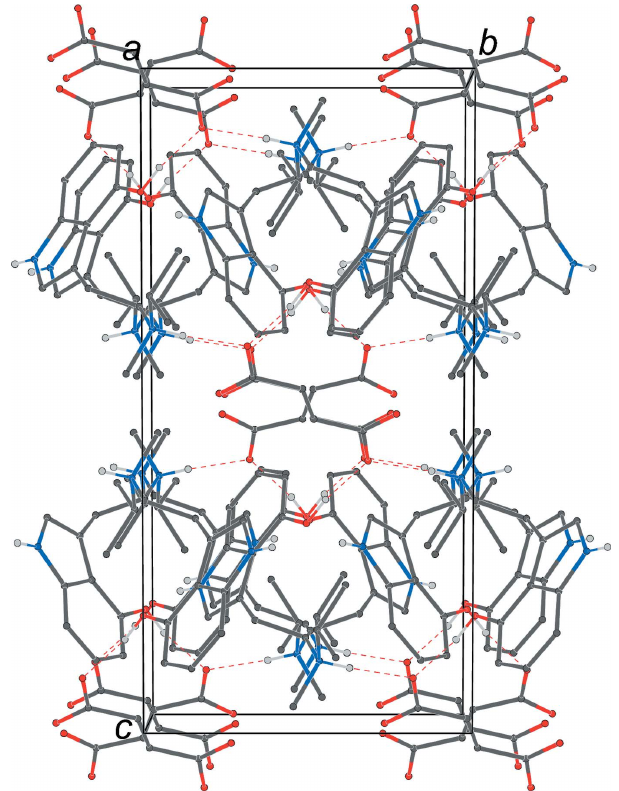
Figure 4 The crystal packing of the title compound, viewed along the a axis. The N—H (cid:2)(cid:2)(cid:2) O and O—H (cid:2)(cid:2)(cid:2) O hydrogen bonds (Table 1) are shown as dashed lines. Hydrogen atoms not involved in hydrogen bonding are omitted for clarity.